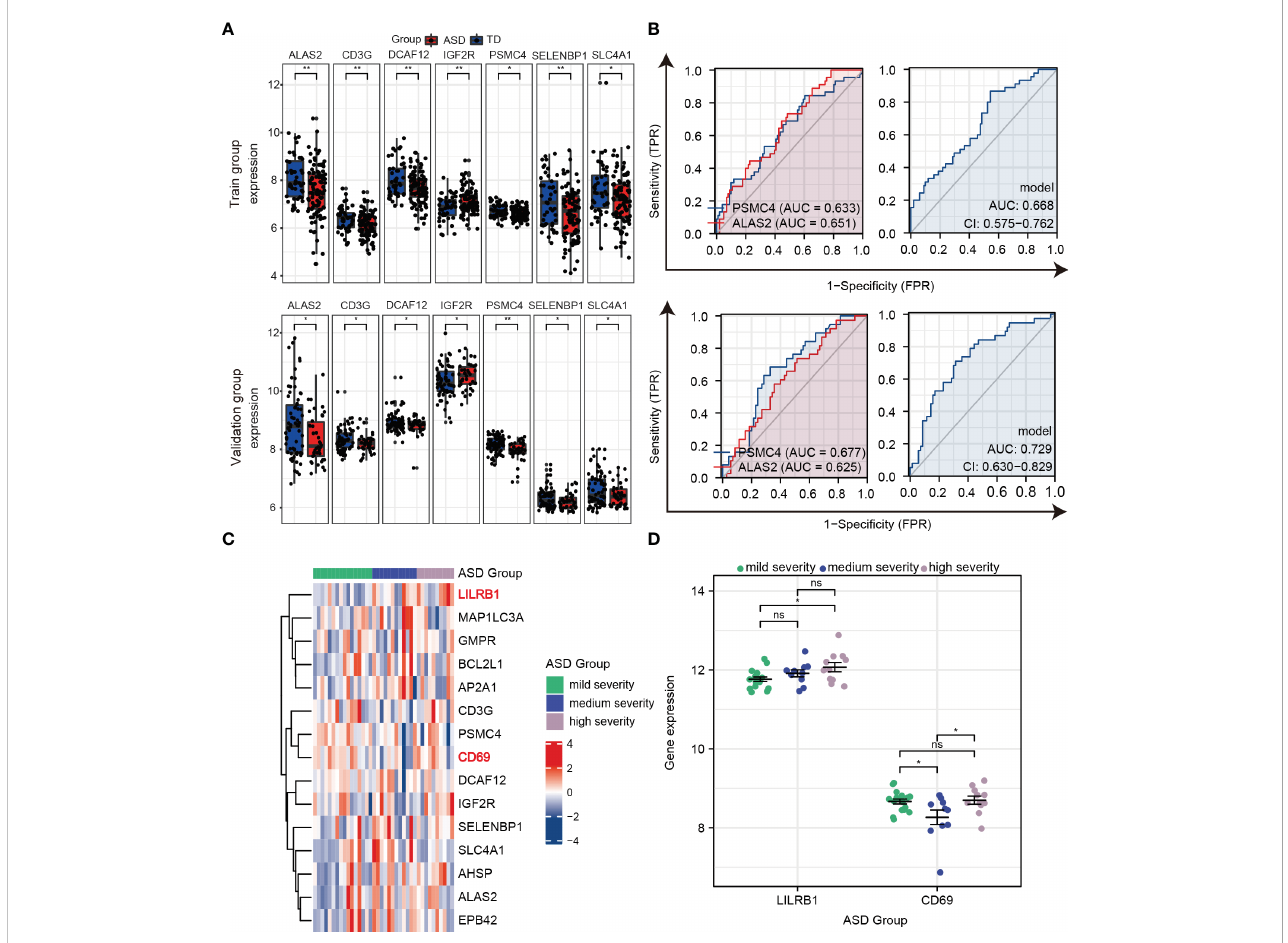
FIGURE 7 Verifying the predictors from hub genes in the training and validation groups. (A) Seven hub genes with consistent changes in expression levels in the training group (top) and validation group (bottom). (B) ROC curve and logistic regression model to assess the predictive accuracy of PSMC4 and ALAS2 in the training group (top) and validation group (bottom). (C) Heat maps of the expression of 15 hub genes in the three groups according to ASD severity. (D) Prognostic values for LILRB1 and CD69 in dot plots. ns, not signi fi cant; * p < 0.05; ** p < 0.01.